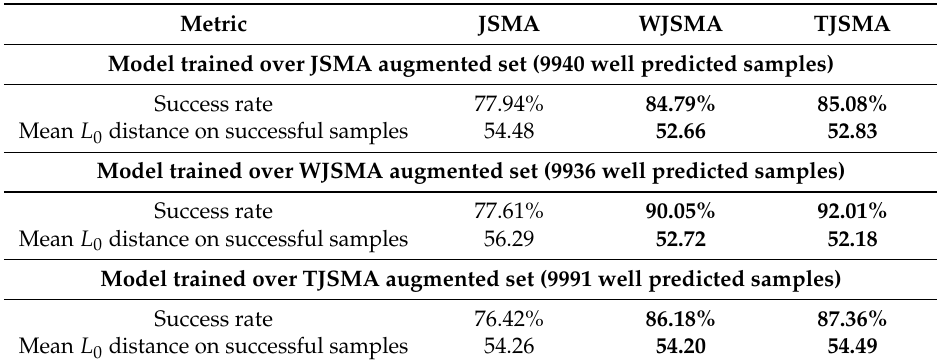
Table 4. Metrics (1) and (2) on JSMA, WJSMA and TJSMA augmented sets.